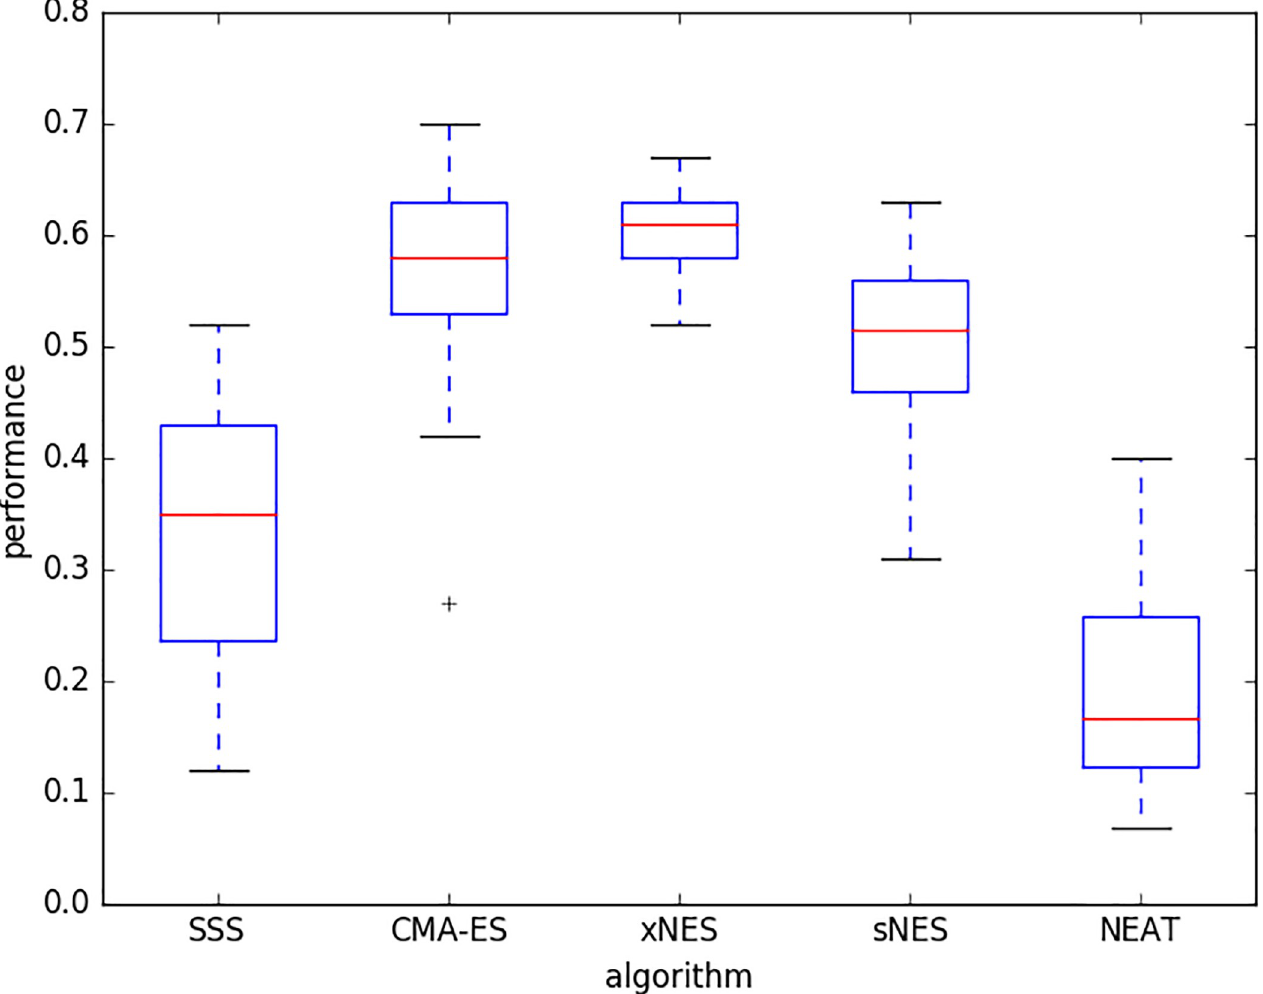
Fig 6. Performance of the best candidate solutions post-evaluated for 500 trials. Experiments performed with the best combination of parameters for each algorithm: SSS (F = 0.1, NEE = 20); CMA-ES (F = 0.04, NEE = 20); xNES (F = 1.0; NEE = 100); sNES (F = 1.0, NEE = 100); NEAT (F = 0.02, NEE = 20). Boxes represent the inter-quartile range of the data and horizontal lines inside the boxes mark the median values. The whiskers extend to the most extreme data points within 1.5 times the inter-quartile range from the box. “+” indicate the outliers. Data obtained by running 40 replications.